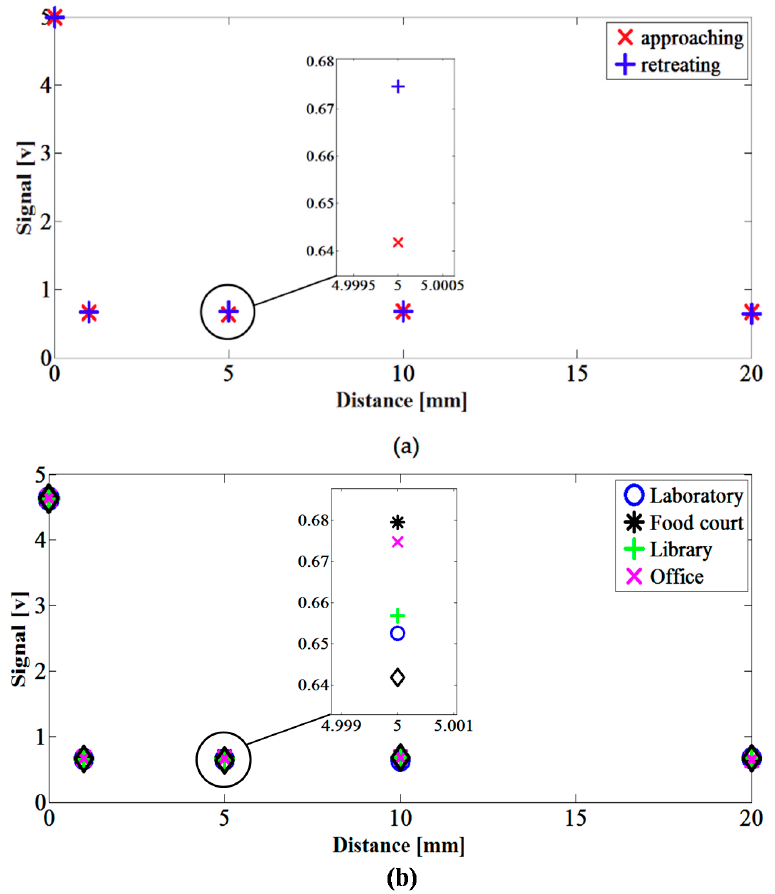
Figure 6. Voltage magnitude vs. distance between finger and keyboard. ( a ) Voltage detected while approaching and backing away from the keyboard; ( b ) Voltage detected in various environments.